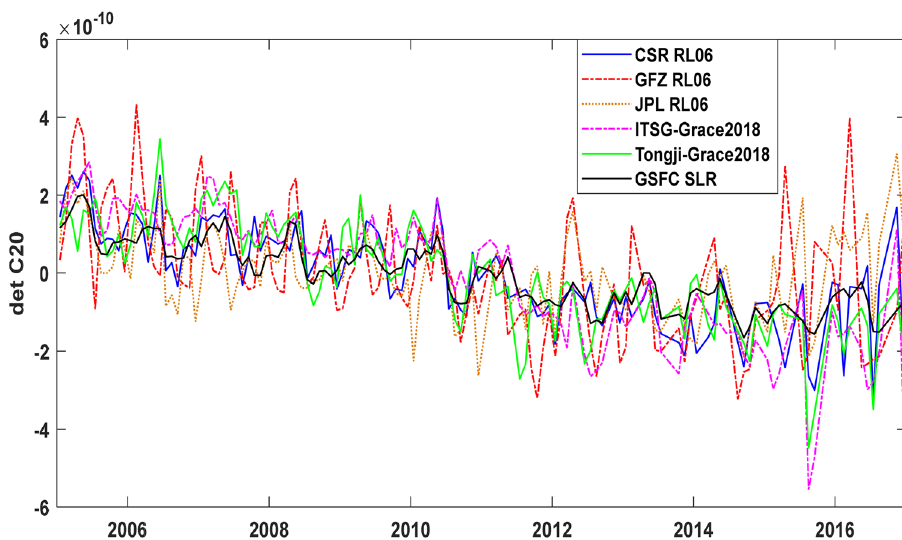
Figure 5. Comparison of (cid:31) C 20 from five GRACE solutions and NASA GSFC SLR solution.